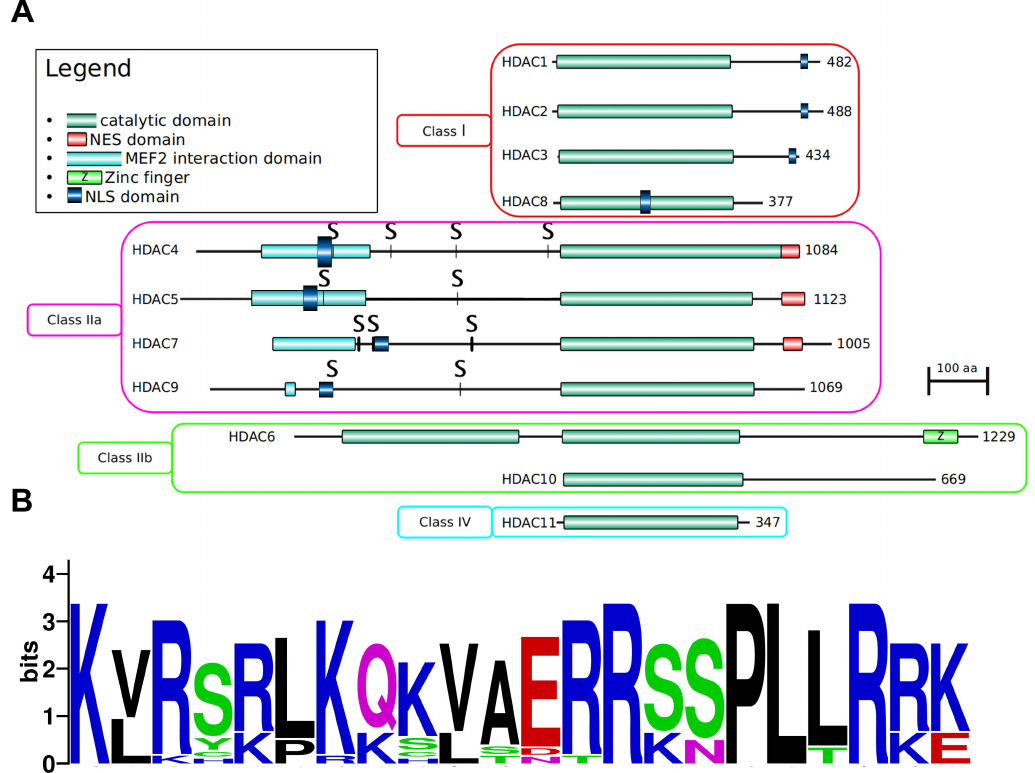
Figure 2. ( A ) Domain architecture of HDAC proteins (human HDACs are used as reference). S indicate Serine residuals phosphorylated by CaM kinases [41]. ( B ) Sequence logo of Class IIa HDAC NLS sequence across human, mouse, chicken, and zebrafish proteins. Amino acid coloring indicates their predominant chemical property (blue: basic; red: acidic; green: polar; black: hydrophobic; purple: neutral). Logo generated with WebLogo